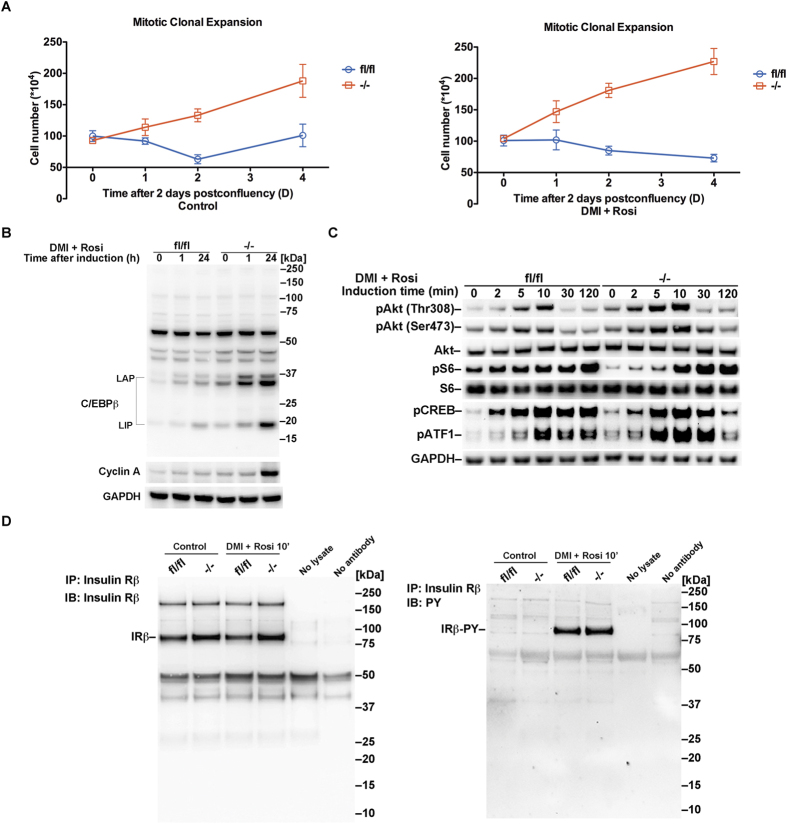
Txnrd1 depletion causes accelerated mitotic clonal expansion and sensitizes MEFs to insulin signaling upon adipocyte differentiation induction.(A) Txnrd1fl/fl and Txnrd1−/− MEFs were either kept in culture two days after reaching confluency or hormonally induced to adipocyte differentiation as indicated and described in the text. Total cell numbers at different time points were counted and then plotted as shown (n = 4, ±SEM). Left panel are untreated controls with the right panel showing the hormonally induced cells. (B) The lysates of cells obtained at the different time points shown in (A) were immunoblotted using antibodies against C/EBPβ and cyclin A, with immunoblotting for GAPDH used as loading control. Sizes of the LAP and LIP forms of C/EBPβ are indicated. (C) Txnrd1fl/fl and Txnrd1−/− MEFs were hormonally induced for adipocyte differentiation and analyzed at different time points as indicated. The cell lysates were immunoblotted with antibodies against pAkt (Thr308), pAkt (Ser473), total Akt, pCREB, pATF1, pS6 or total S6, with immunoblotting of GAPDH used as loading control. Only the parts of the membranes corresponding to the expected sizes of the target proteins are shown. (D) Txnrd1fl/fl and Txnrd1−/− MEFs were treated for hormonal induction of adipocyte differentiation for 10 min, whereupon cell lysates were used for immunoprecipitation with an antibody against insulin receptor β subunit. The pulled down samples were subsequently immunoblotted with antibodies against the insulin receptor β subunit (left) and phosphotyrosine (PY)-containing proteins (right), as indicated. See Supplementary Material for non-cropped immunoblots.